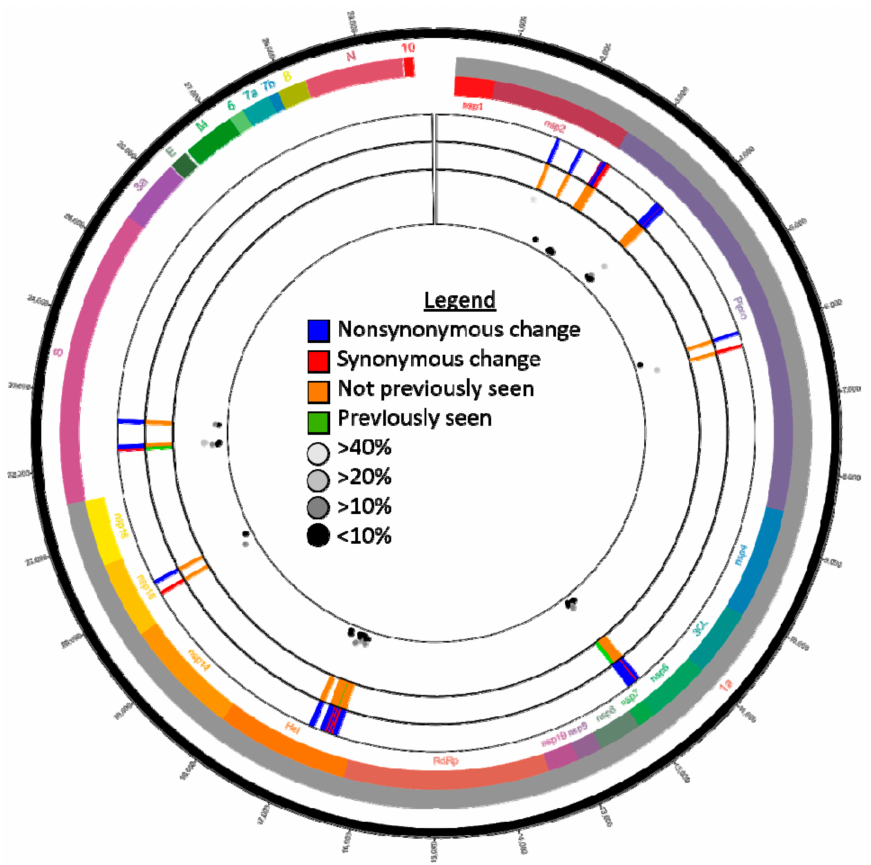
Figure 1. Subconsensus variants identified in hCoV-19/dog/USA/KS-8074/2021 (GISAID